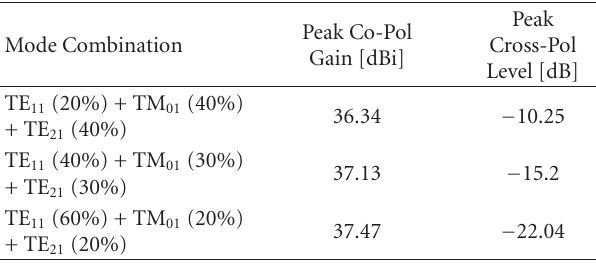
Table 2: Peak copolarization gain and peak cross-polarization levels (below peak gain) at 7.73GHz for +90 ◦ phase with di ff erent amplitude